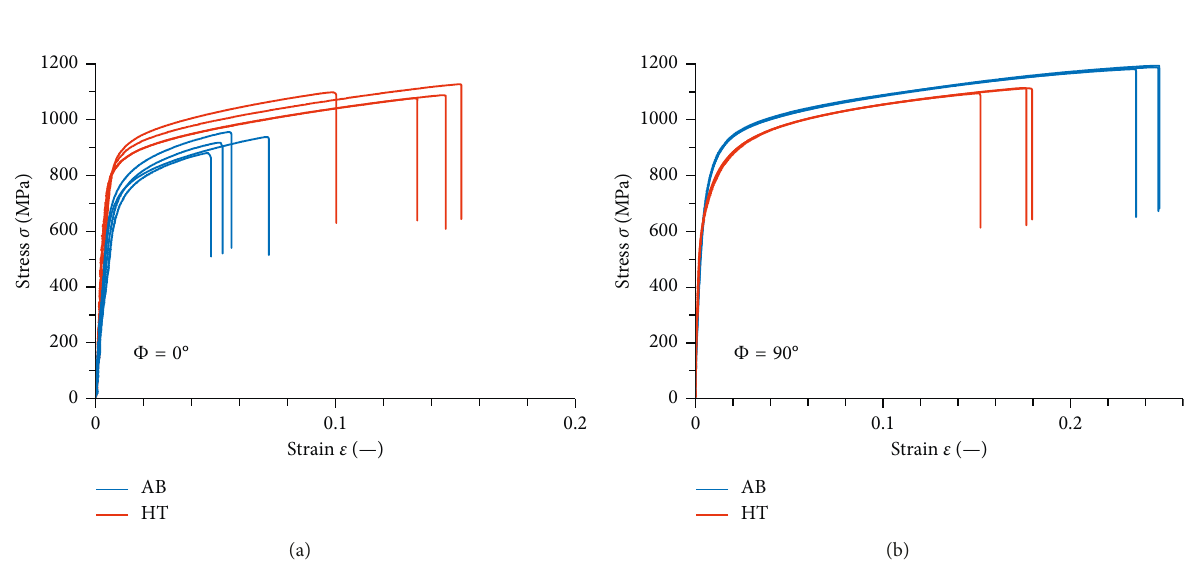
Figure 6: Representative stress-strain graphs of Co-Cr-Mo (a) and Co-Cr-W (b)